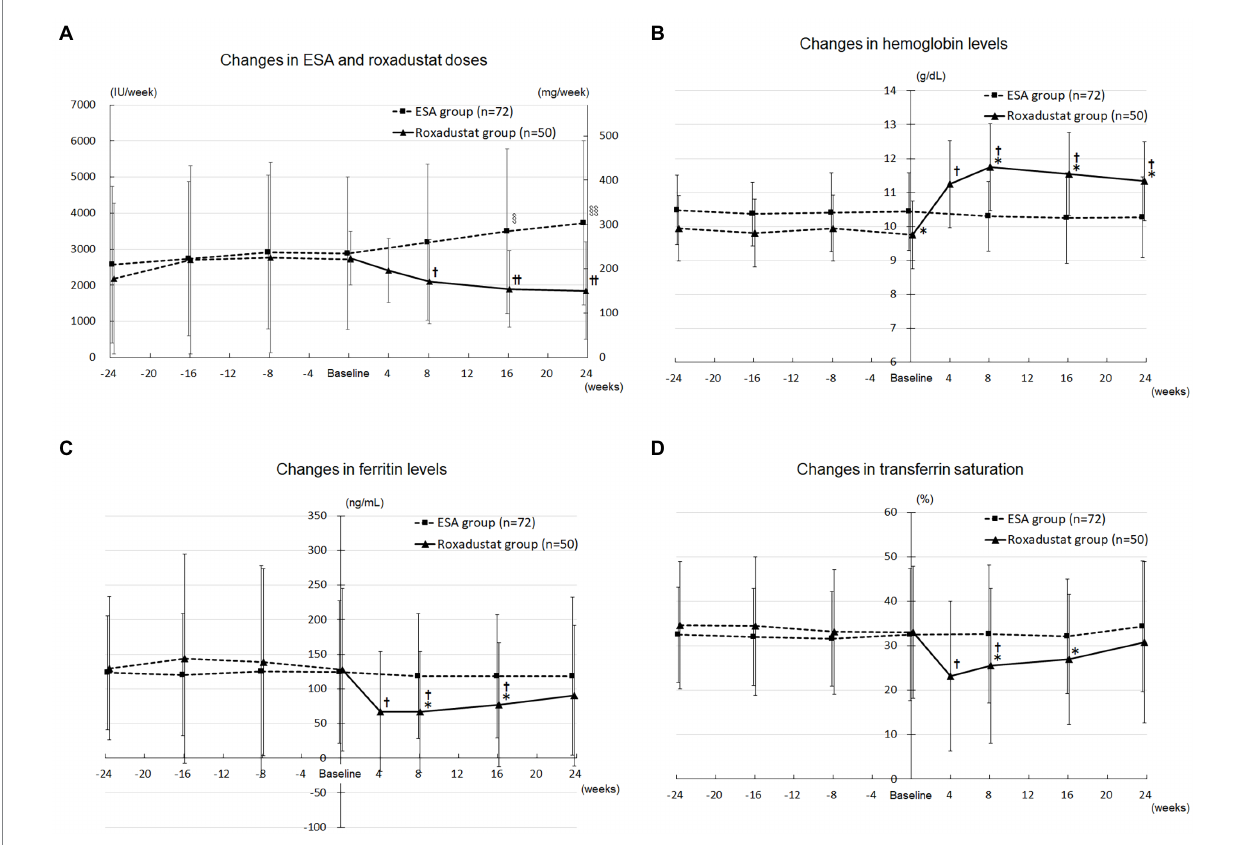
FIGURE 3 Anemia and iron metabolism. (A) Changes in the ESA (IU/wk) and roxadustat (mg/wk) doses administered during the study. (B) Changes in the hemoglobin levels in the roxadustat and ESA groups. (C) Changes in the ferritin levels in the roxadustat and ESA groups. (D) Changes in the transferrin saturation in the roxadustat and ESA groups. ESA, erythropoiesis-stimulating agent; IU, international units. §, value of p < 0.05 versus − 24 weeks, − 16 weeks, and baseline; §§, value of p < 0.05 versus − 24 weeks, − 16 weeks, − 8 weeks, and baseline. †, value of p < 0.05 versus baseline; ††, value of p < 0.05 versus baseline and 4 weeks. *, value of p < 0.05 versus the ESA